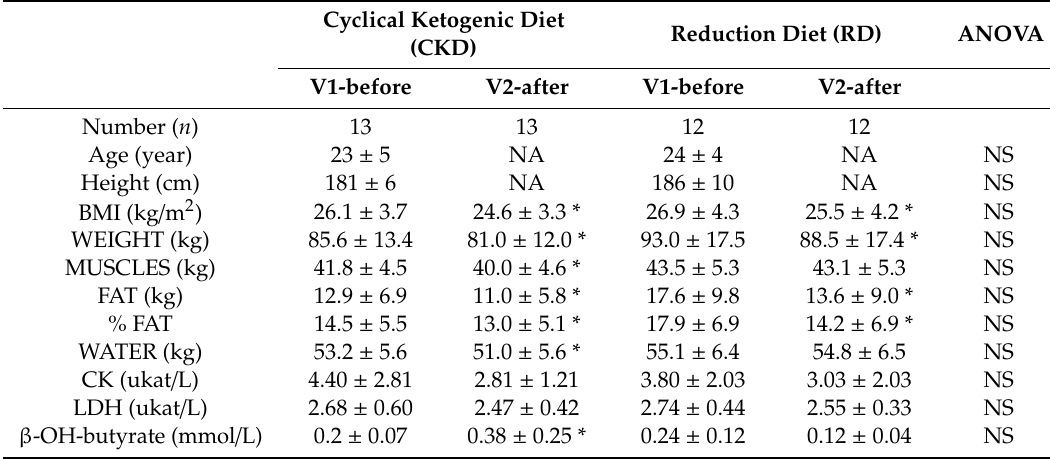
Table 1. Anthropometric and biochemical parameters of subjects on cyclical ketogenic reduction diet or nutritionally balanced reduction diet at baseline and after 8 weeks of